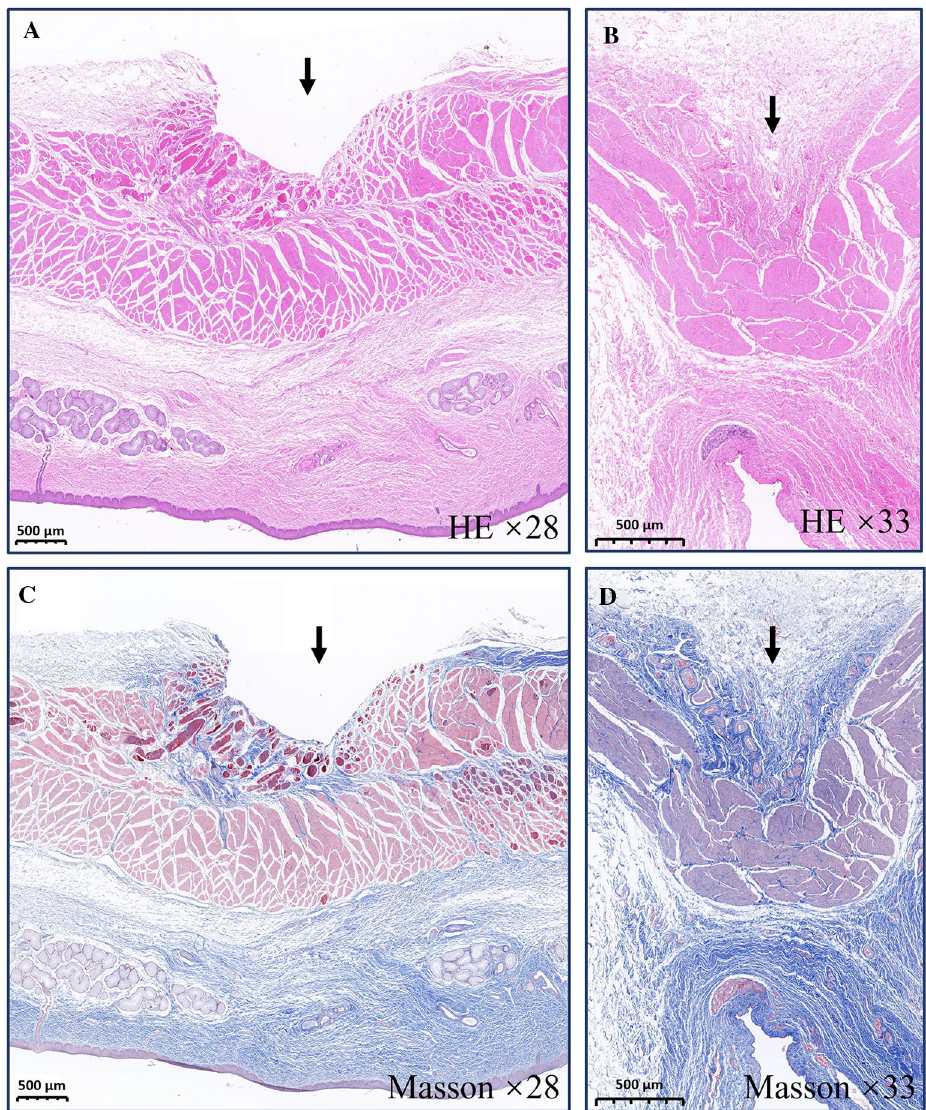
Figure 4. Histological observations. ( A ) HE staining of esophageal specimens (× 28). ( B ) HE staining of the tracheal specimens (× 33). ( C ) Masson’s staining of esophageal specimens (× 28). ( D ) Masson’s staining of the tracheal specimens (×